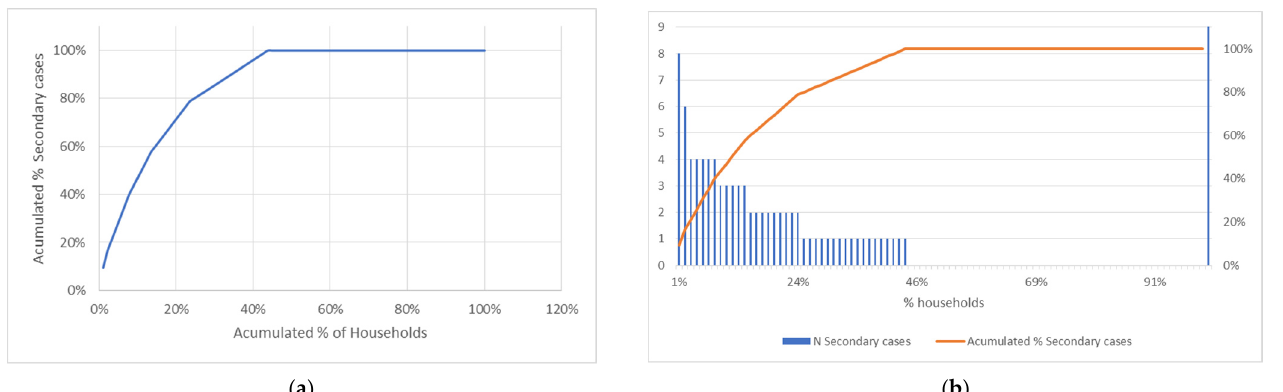
Figure 2. Distribution of cases by households: ( a ) Secondary cases by households ( b ) Pareto’s chart of secondary cases of COVID-19 by households.